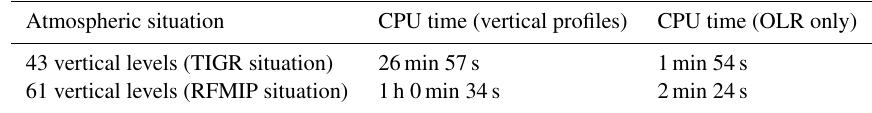
Table 1. CPU time of the complete radiative transfer including calculation of radiative quantities for a single atmospheric situation. Atmospheric situation CPU time (vertical profiles) CPU time (OLR only) 43 vertical levels (TIGR situation) 26min 57s 1min 54s 61 vertical levels (RFMIP situation) 1h 0min 34s 2min